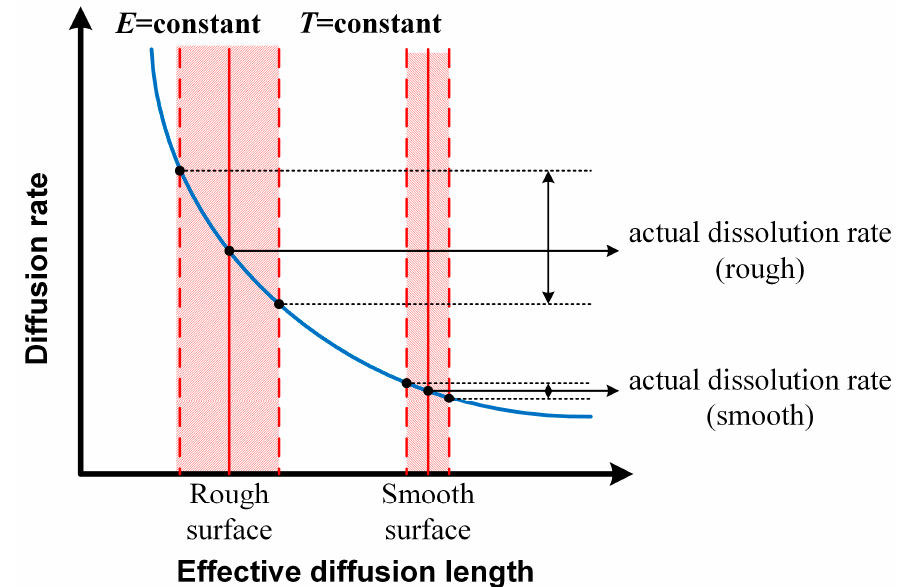
Figure 14. Schematic presentation of the relationships between surface roughness, effective diffusion length, diffusion rate, and actual dissolution rate of metastable pits.